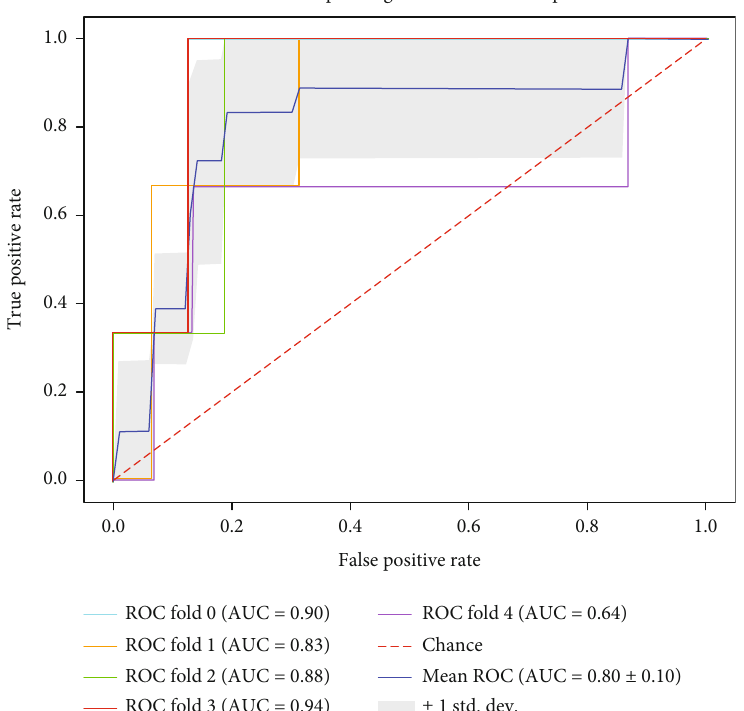
Figure 3: Mean receiver-operating characteristic (ROC) curve of the new prediction score for prediction of OF in tenfold